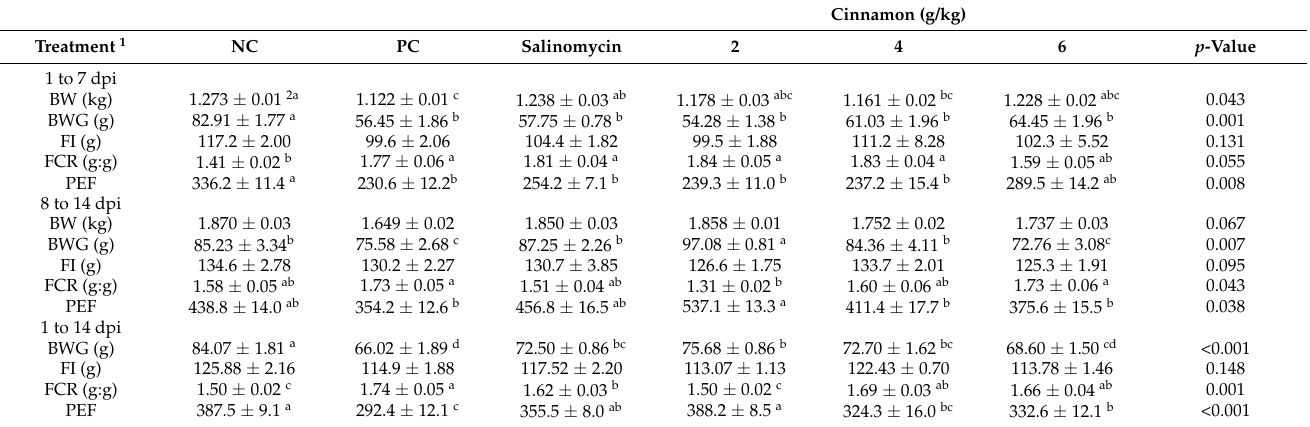
Table 1. Live body weight (BW), average live body gain (BWG), average feed intake (FI), feed conversion ratio (FCR), and production efficiency factor (PEF) of broiler chickens given experimental diets (cinnamon), post coccidial challenge period (0–14 dpi).